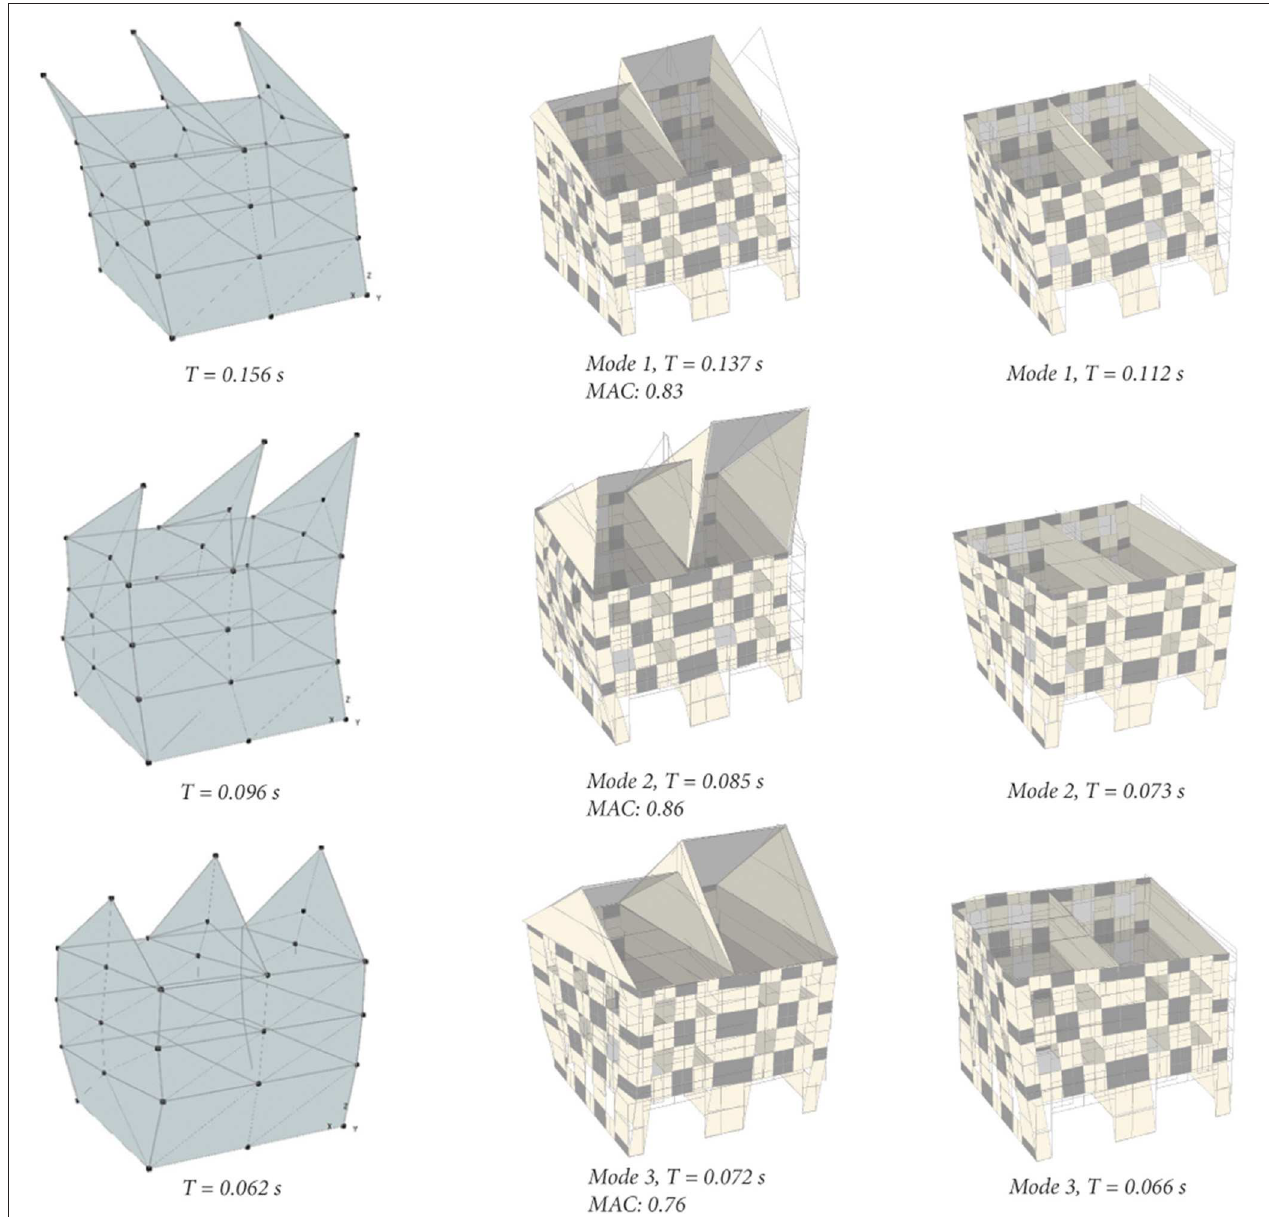
FIGURE 4 | Stone masonry building: modal analysis of the complete model and simplified model without explicitly modeling the gable. Modal shapes and periods are compared to the results of the dynamic